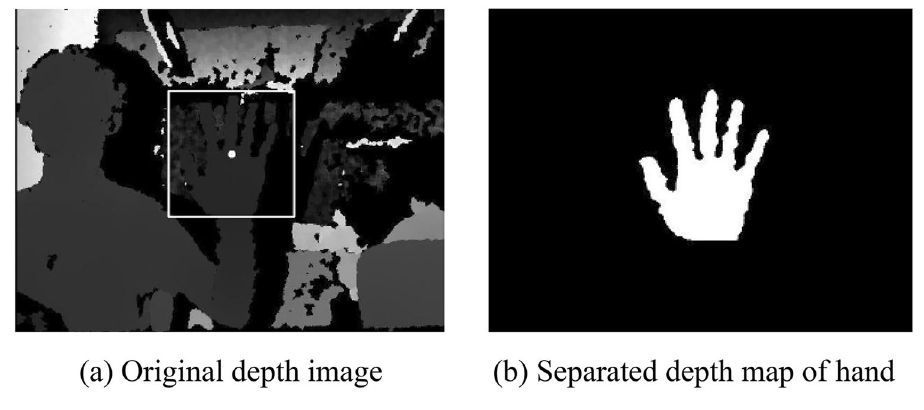
Figure 2. Hand segmentation